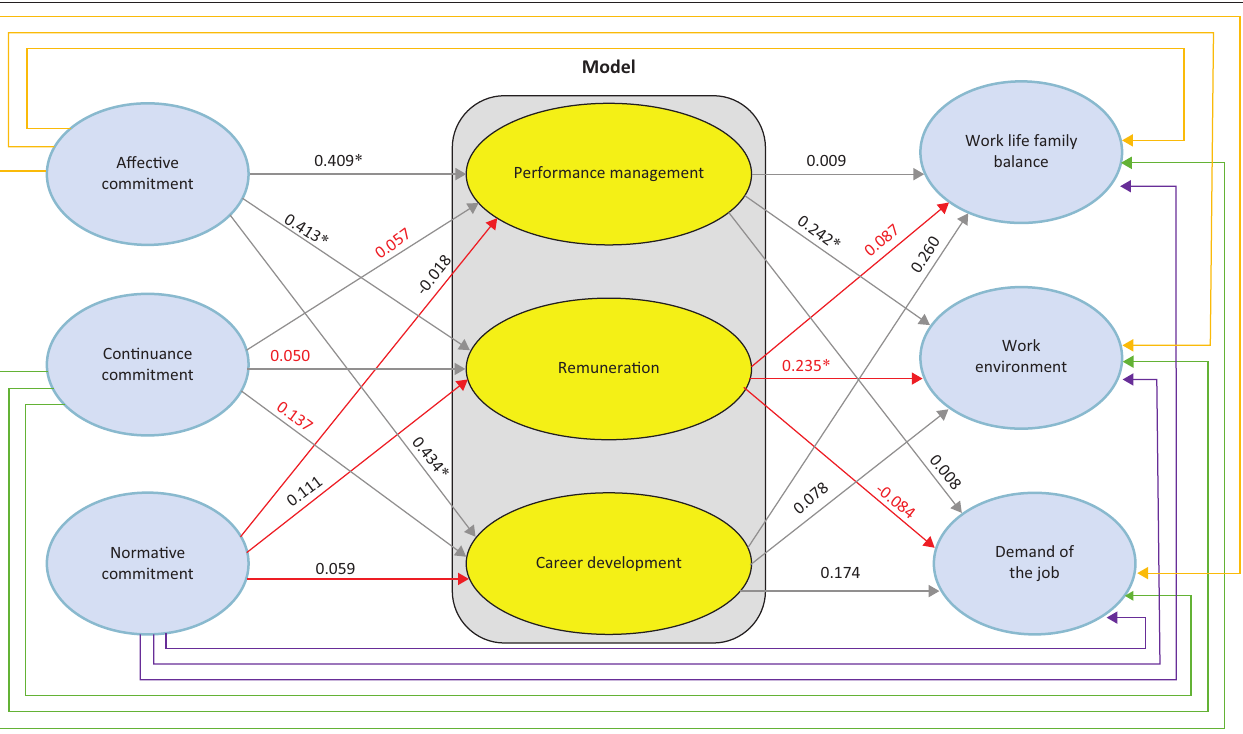
Figure 1 supports the findings based on the bootstrapping method; it shows the direct and indirect relationships between the key